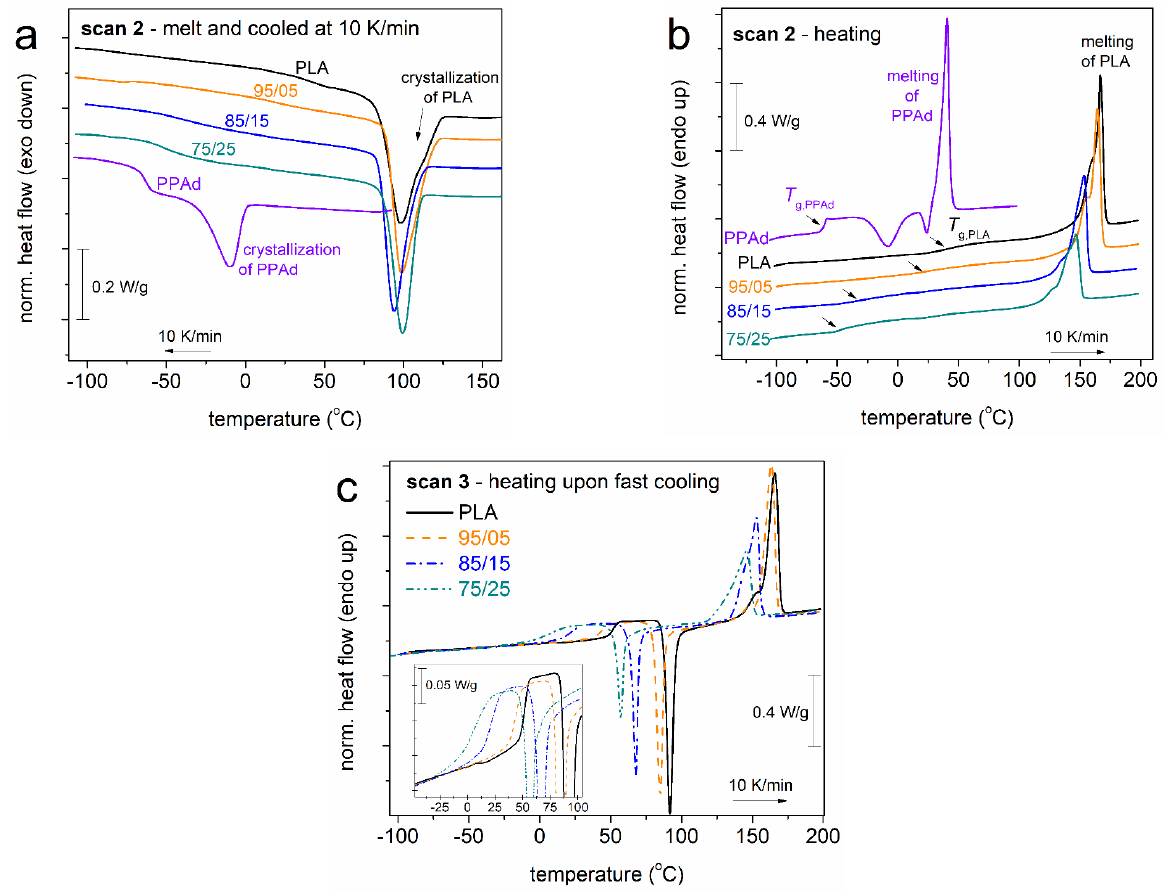
Figure 3. Comparative DSC traces during ( a ) cooling and ( b ) heating at 10 K/min of Scan 2 and ( c ) heating at 10 K/min for all initially amorphous samples previously cooled at a high rate of Scan 3. The recorded heat flow (in mW) is shown upon normalization to the sample mass (W/g). The inset to ( c ) shows the glass transition region in more detail.